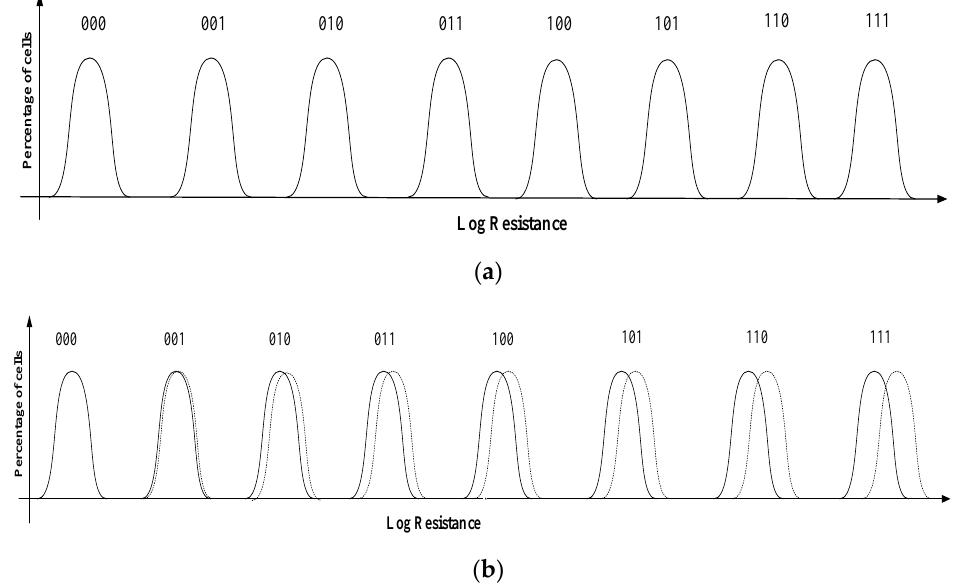
Figure 6. ( a ) The 8-state resistance distribution of PCM with the proposed 2T2R structure. ( b ) Actual resistance distribution of PCM with the proposed 2T2R.